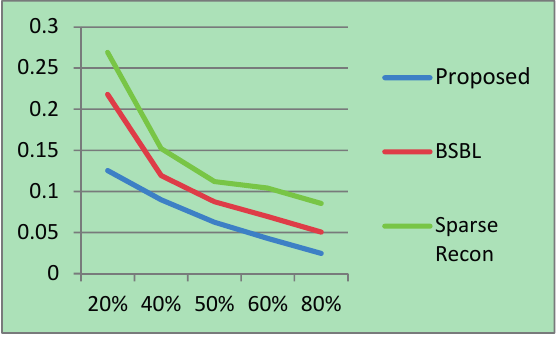
Figure 4. BCI dataset: NMSE on Y -axis, sampling/compression ratio on X -axis.